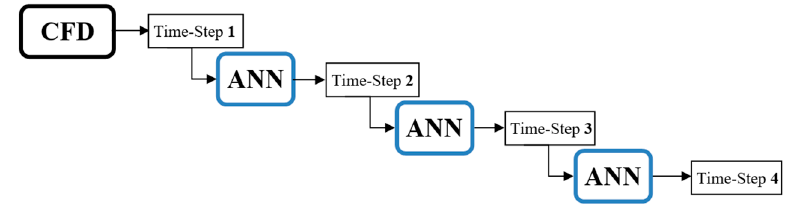
Figure 15. Cascading deployment process.